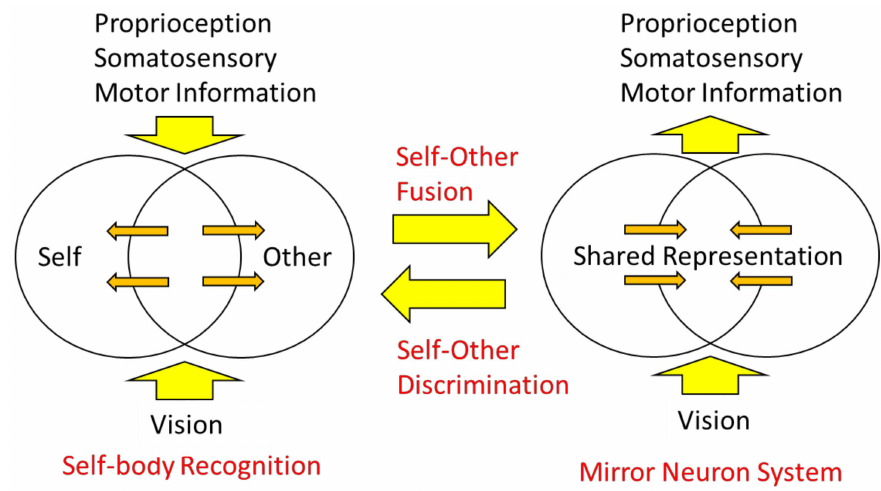
Figure 8. A model for self-body recognition and mirror neuron system. In self-body recognition ( left ), the vision (extrinsic body information) is compared with the intrinsic (proprioceptive, somatosensory, or motor) body information. In the mirror neuron system ( right ), extrinsic body information drives intrinsic, especially motor, body representation.